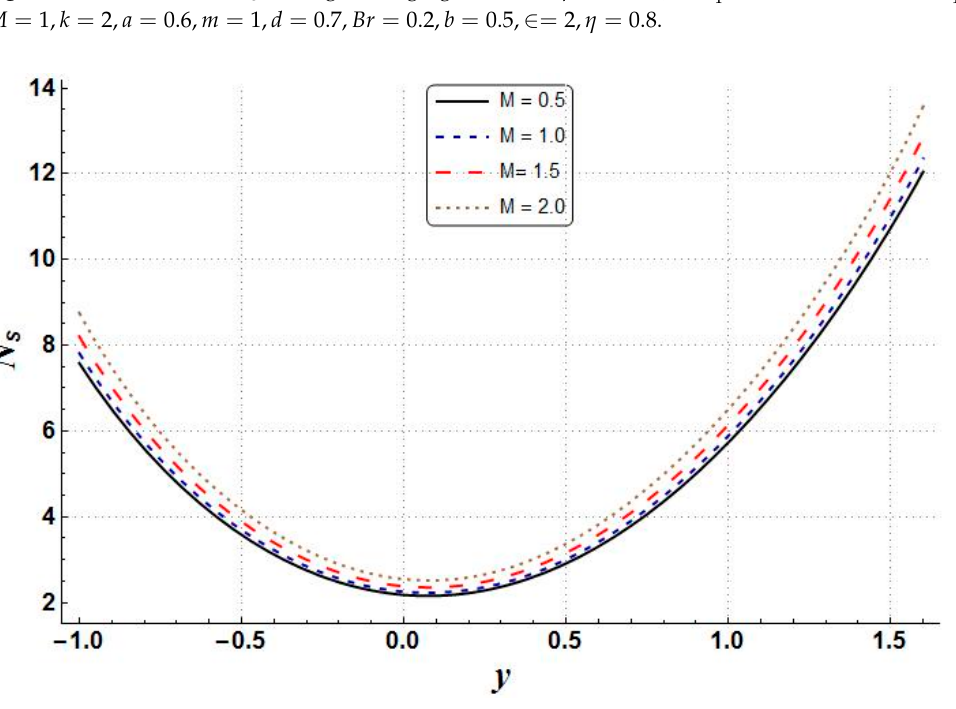
φ , where , x = 0, Gr = 2, α = π , 4 4